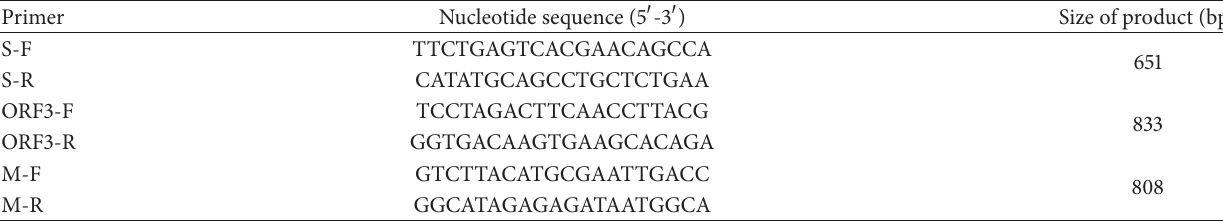
Table 2: Primers used in RT-PCR for PEDV spike, ORF3, and membrane